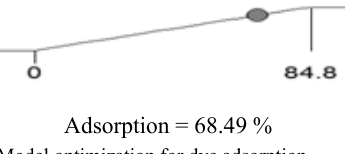
Fig. 5: Model optimization for dye adsorption Table 3 Regression coefficients for fitted model